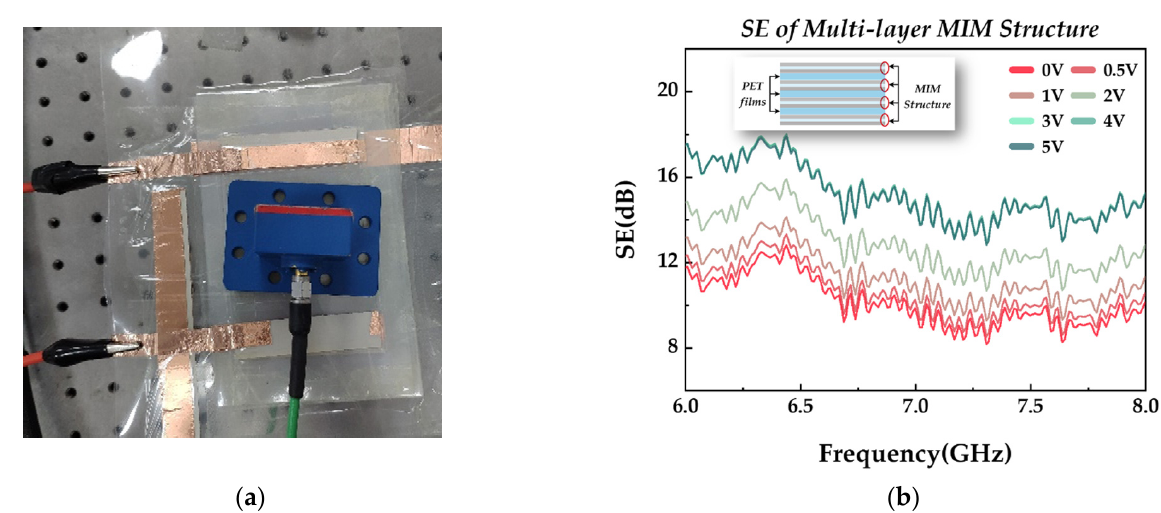
Figure 7. ( a ) The experimental photo of multilayer MIM structure; ( b ) shielding effectiveness of multilayer MIM structure with different voltages.